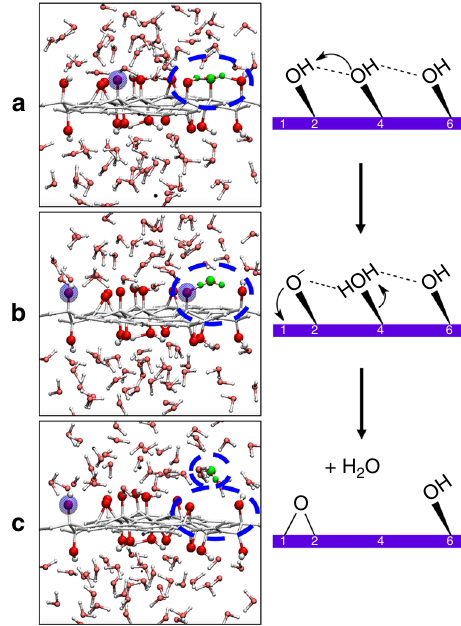
Fig. 4 Spontaneous dehydration of the graphene oxide. We highlight the proton transfer induced by the presence of a strong hydrogen bond network. a , b , and c are snapshots along the MD trajectory of the semiordered 4 model displayed in blue in Fig. 5. The leaving water molecule is colored in green. Schematics are presented on the right side, for clarity. See Fig. 3 for color scheme. This reactive motif of three consecutive hydroxyl groups linked by two intramolecular hydrogen bonds is only present in semiordered model 4 and colored in light green in Fig. 1.